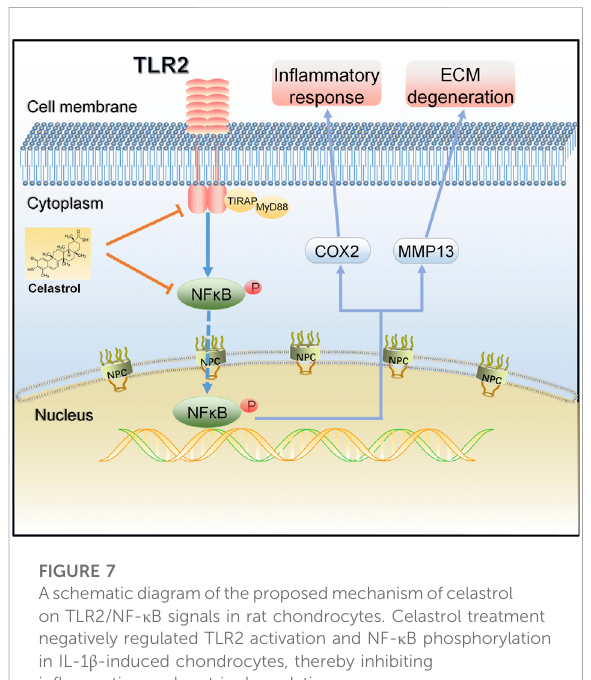
FIGURE 7 Aschematicdiagramoftheproposedmechanismofcelastrol on TLR2/NF- κ B signals in rat chondrocytes. Celastrol treatment negatively regulated TLR2 activation and NF- κ B phosphorylation in IL-1 β -induced chondrocytes, thereby inhibiting in fl ammation and matrix